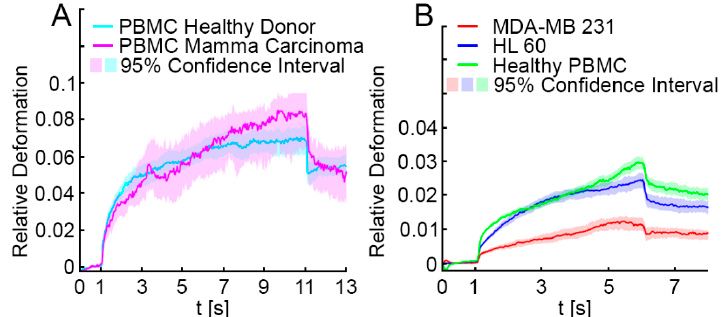
Figure 2. Relative deformation curves of blood cells and MDA-MB 231 and HL-60. (A) PBMC from healthy donors (cyan line, n = 3) and from patients with breast cancer (magenta line, n = 2) exhibited the same deformation behavior, here shown in a representative example at 1200 mW stretching